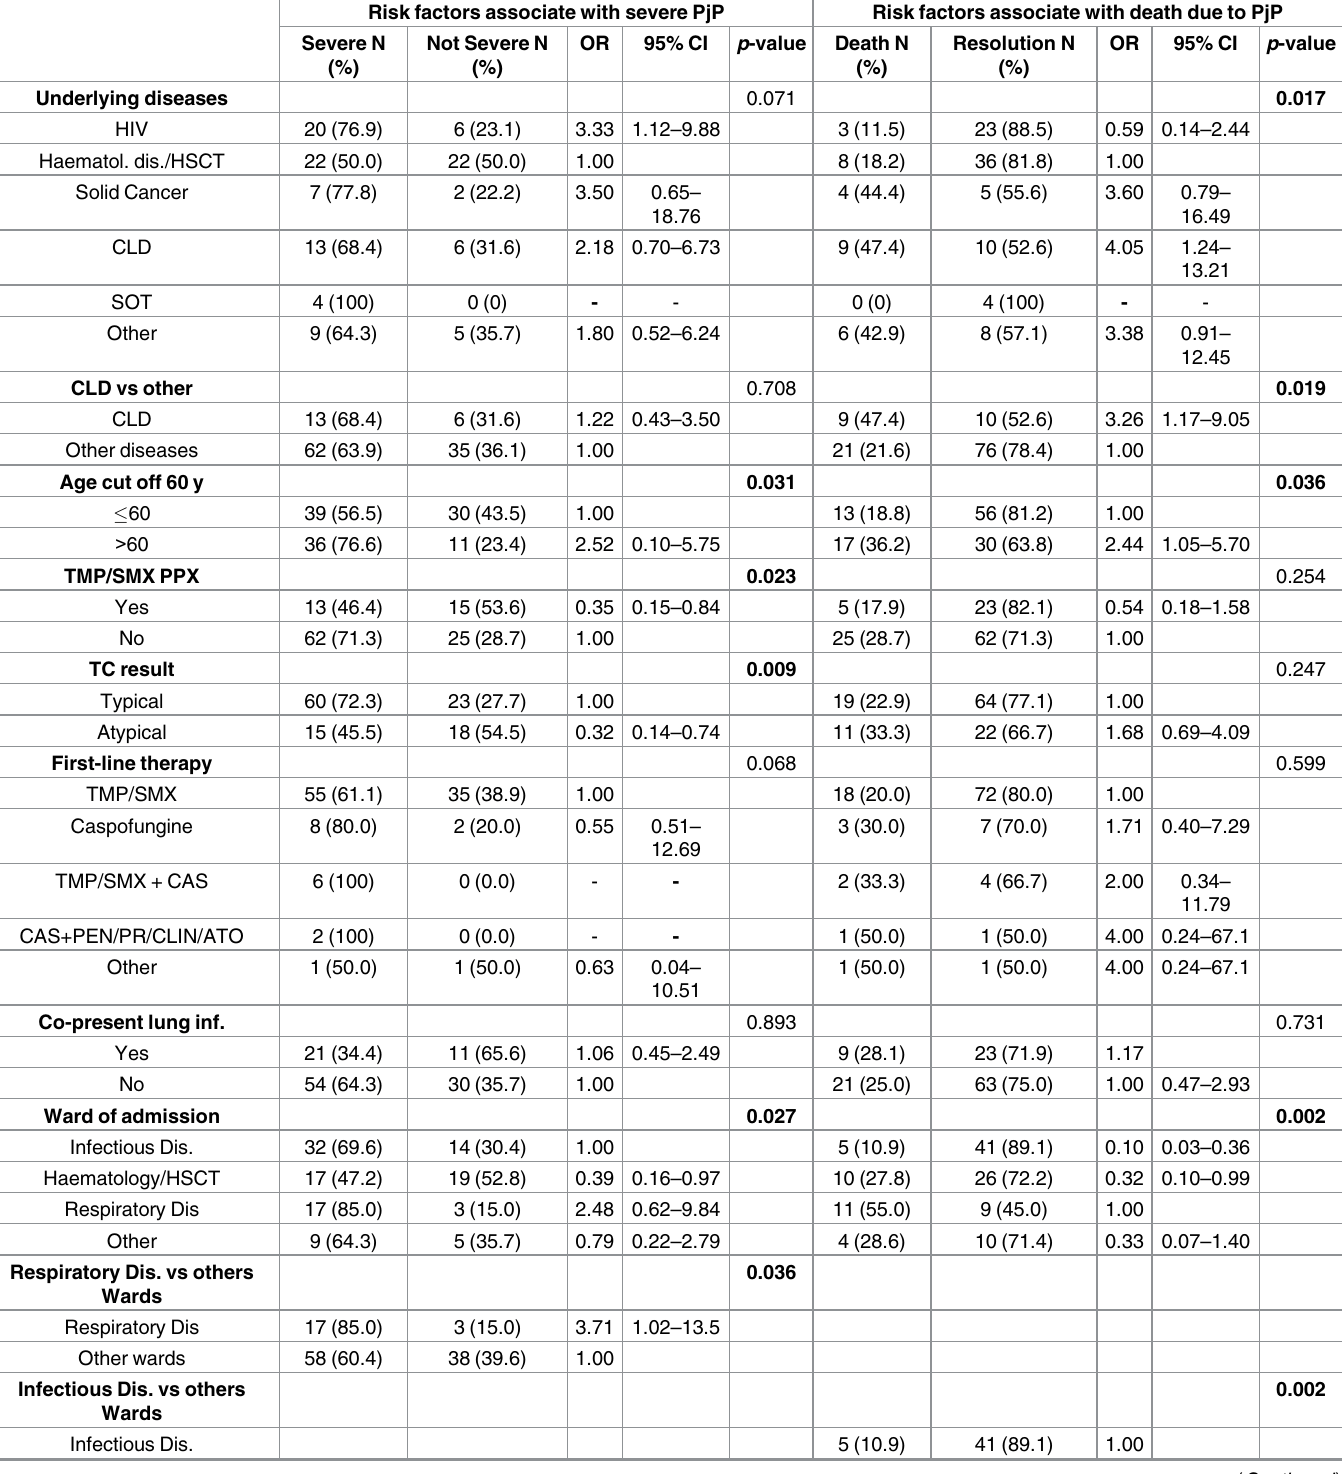
Table 2. Univariate analysis of risk factors associate with severepneumonia and death in 116 patients with PjP. Risk factors associate with severe